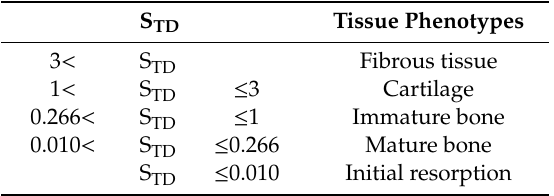
Table 2. The ranges of biophysical stimulus for di ff erent tissue phenotypes. S